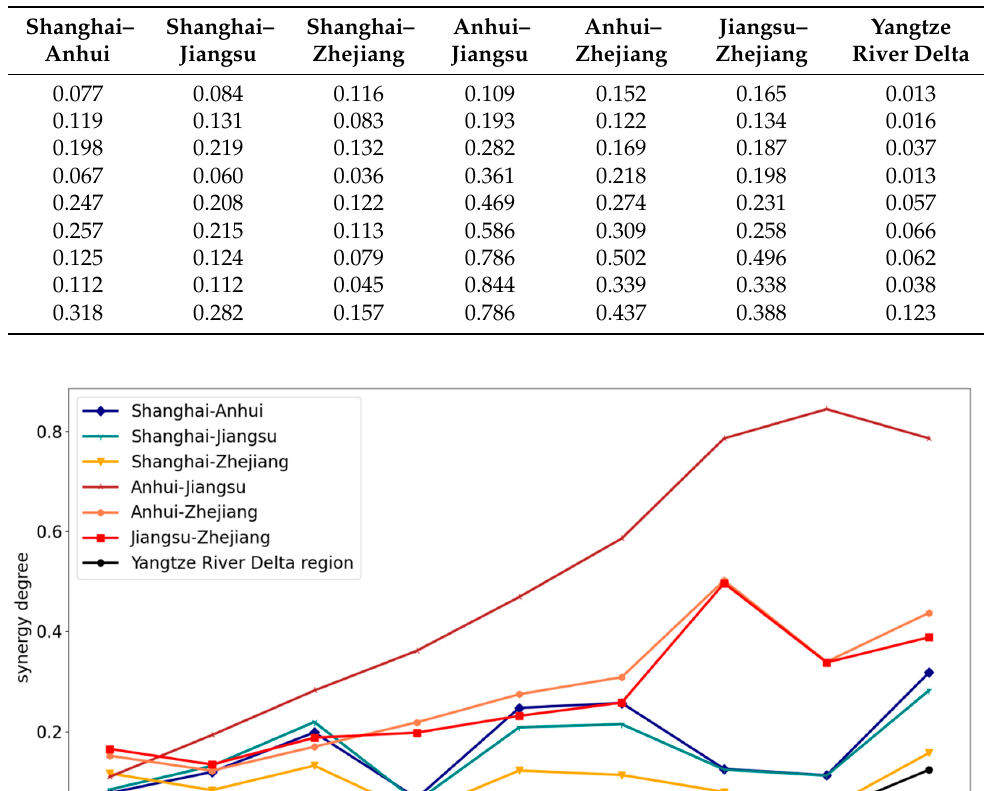
Table 5. Synergetic degree of different subsystems in the YRD region.